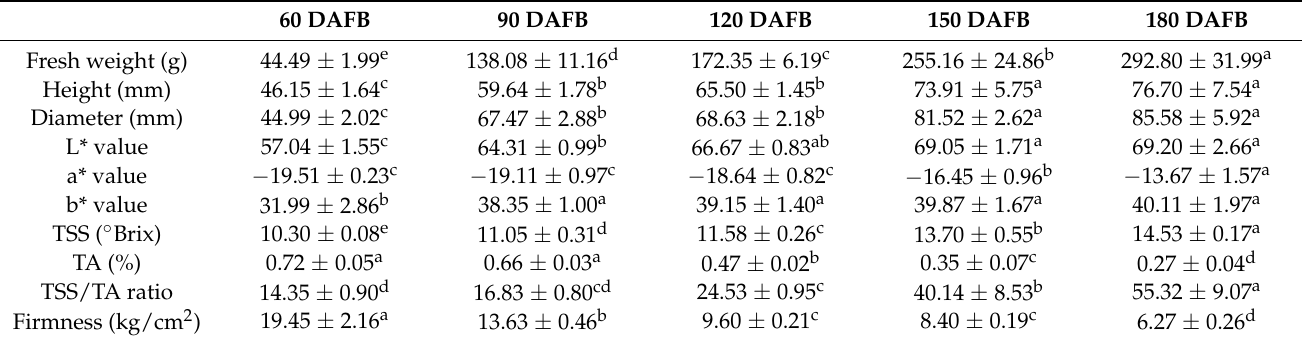
Table 1. Physiological characteristics of ‘Orin’ apple at different ripening